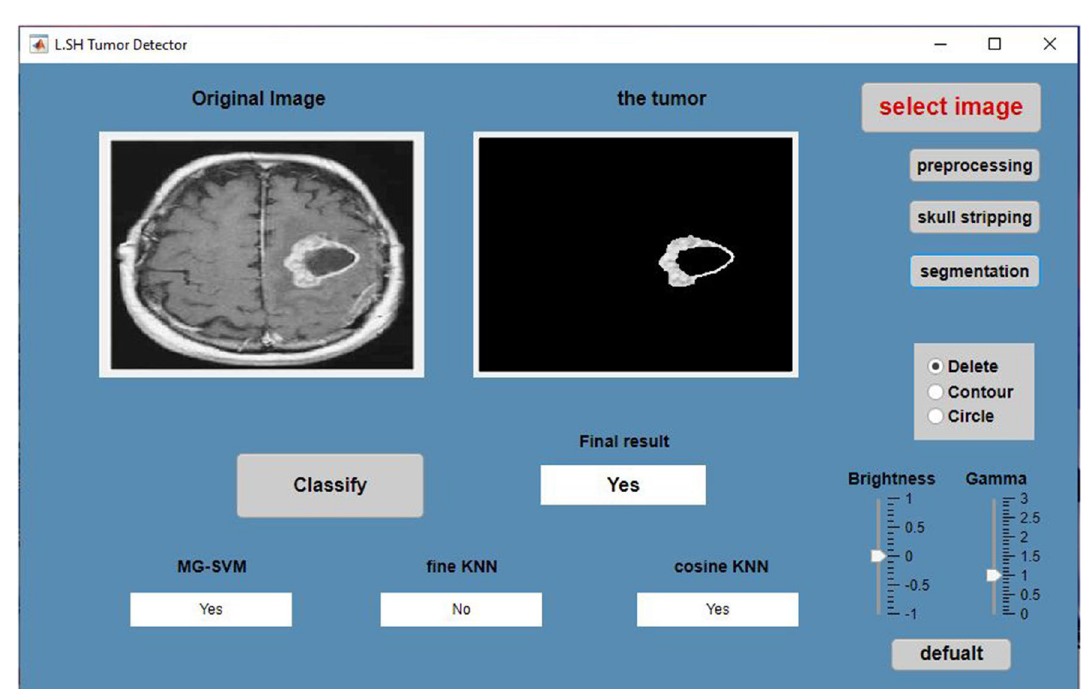
Fig. 7 The graphical user interface